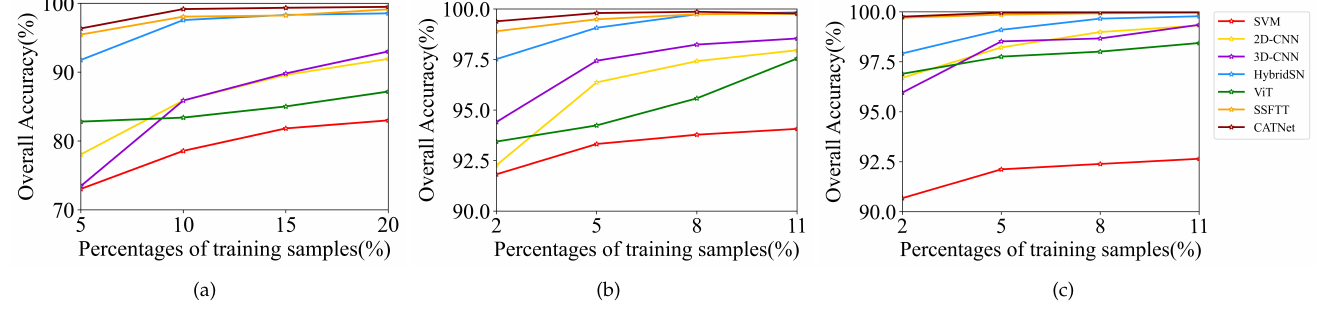
Figure 15. The OAs of the SDFE method and other baselines at different training sample percentages. ( a ) IP dataset. ( b ) PU dataset. ( c ) SA dataset.